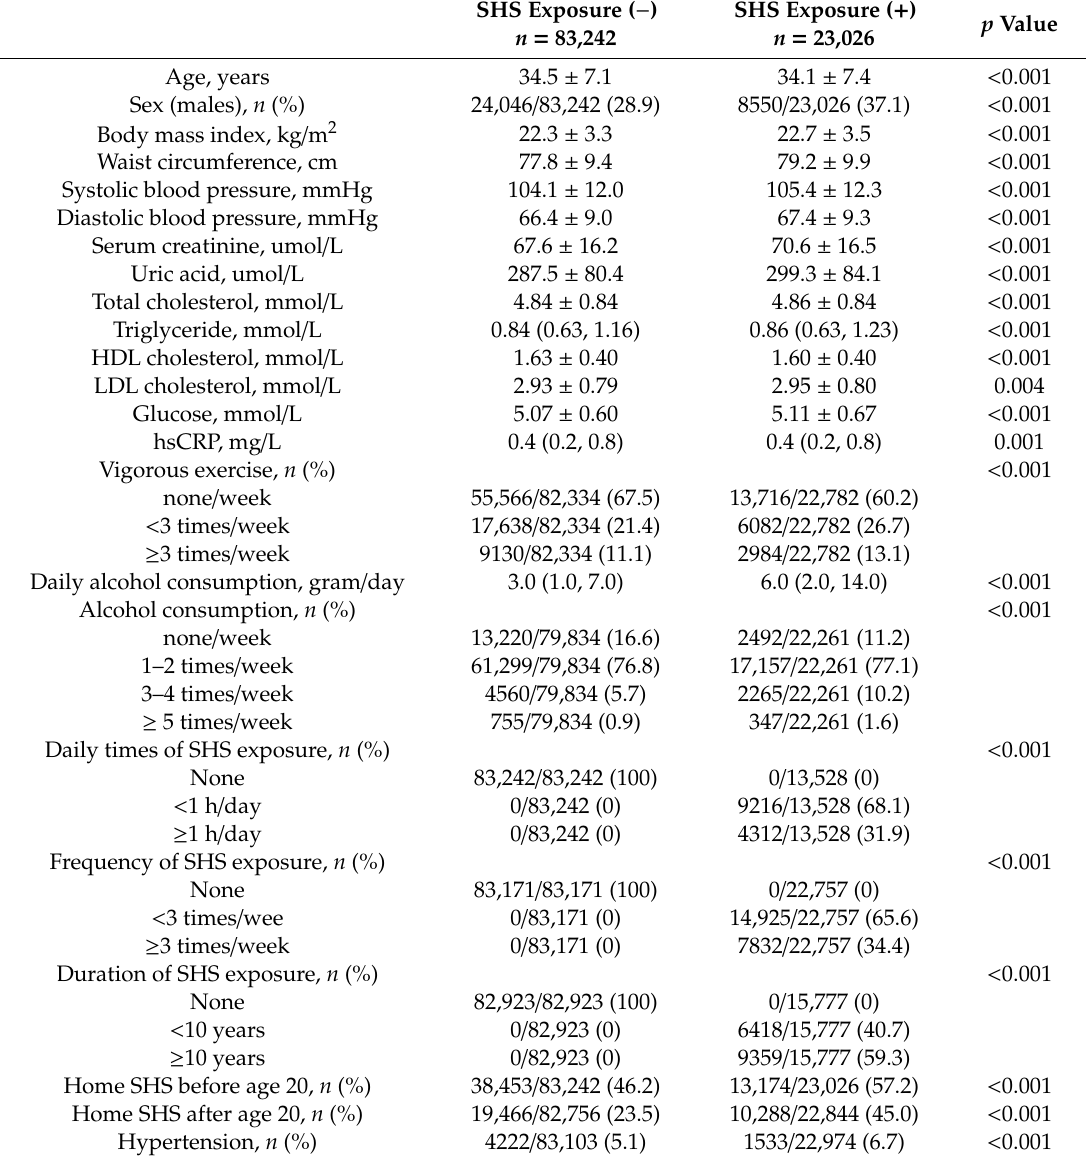
Table 1. Characteristics of never-smokers with and without secondhand smoke